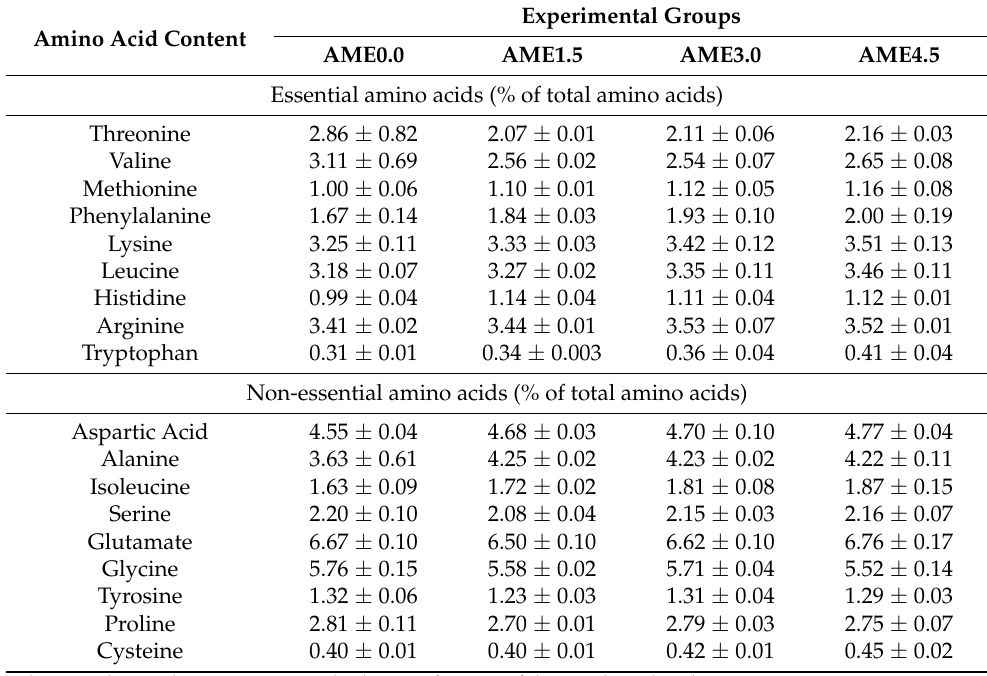
Table 4. Effects of dietary AME levels on the amino acid composition (% of total amino acids) retention in the whole-body of striped catfish